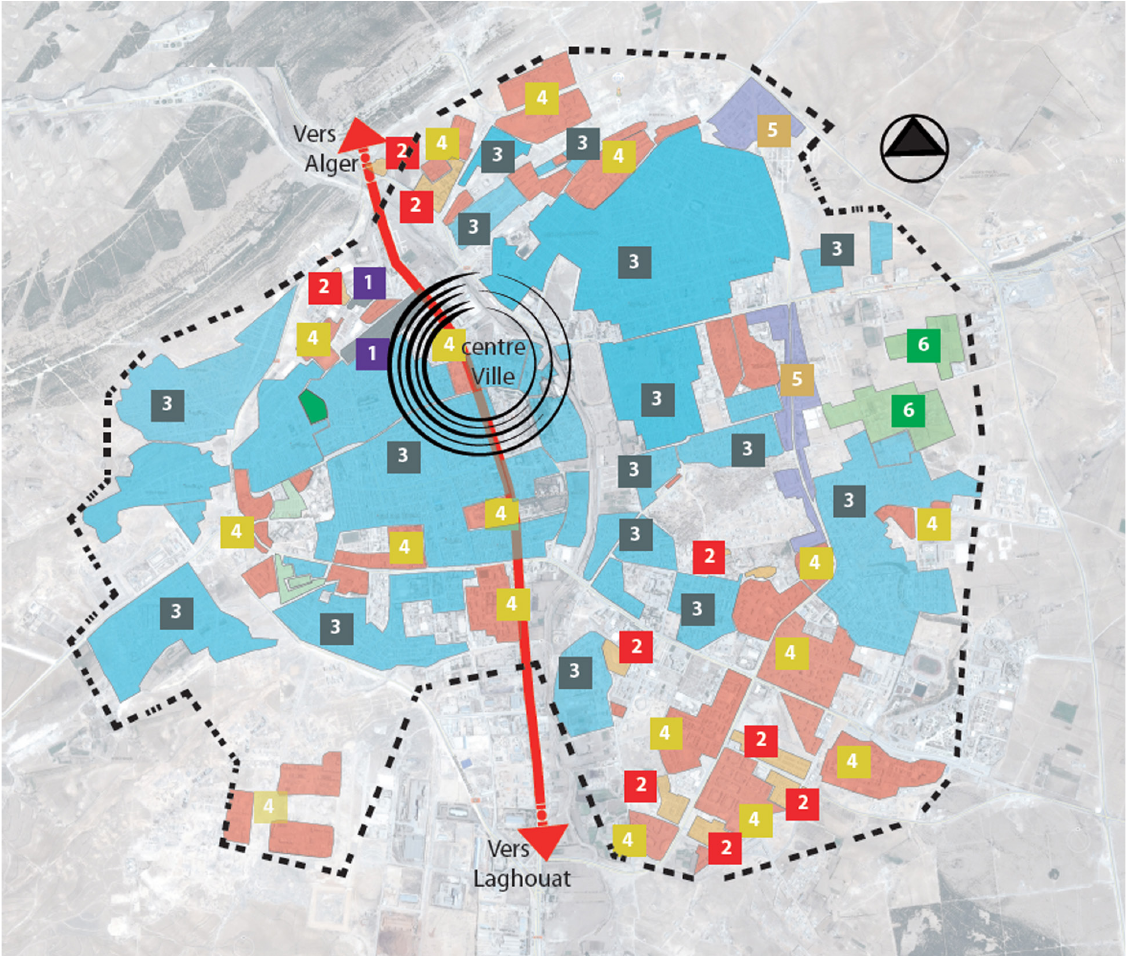
Fig. 5. Study area and types of housings in the municipality of Djelfa. 1 – Very compact individual housing, 2 – Identical individual housing, 3 – Individual housing of housing estate type, 4 – Discontinuous collective housing, 5 – High continuous collective housing, and 6 – Village housing. The discontinuous line represents the study area. Source: own